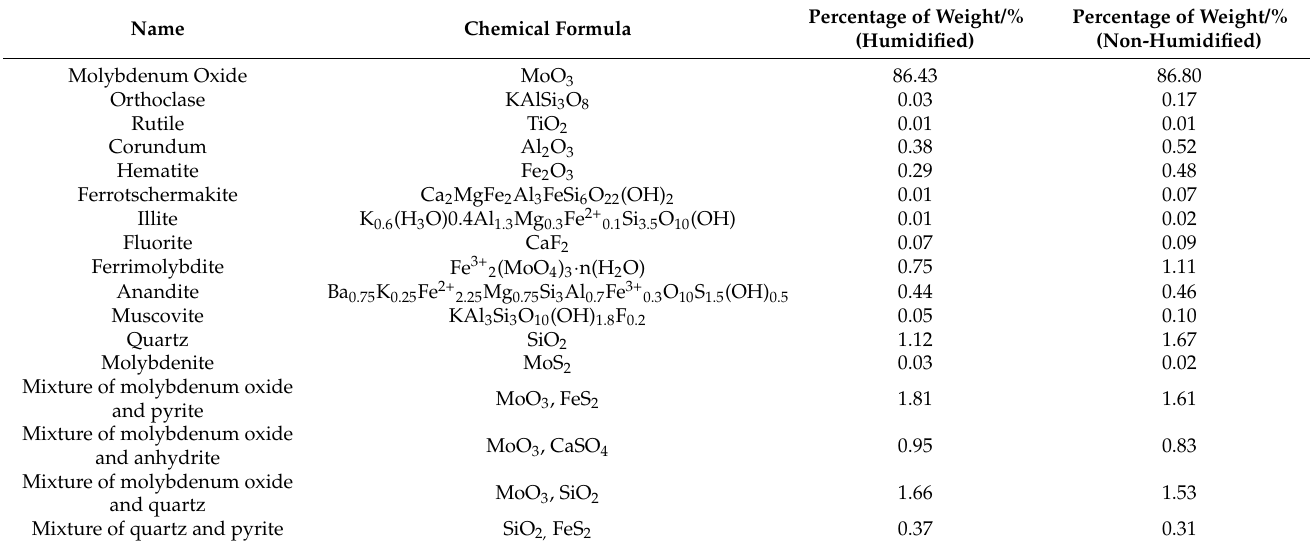
Table 5. MLA analysis results of washed molybdenum calcine under different